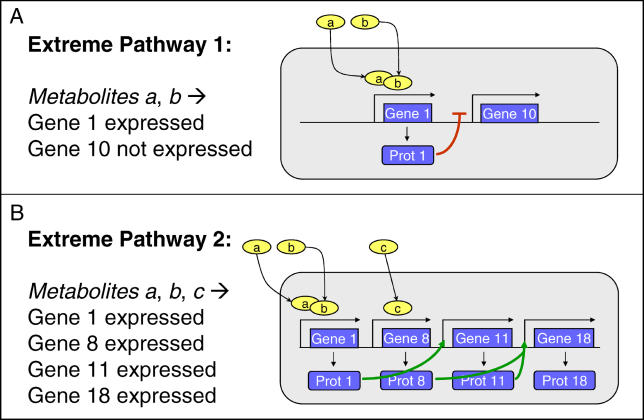
Extreme Pathways for the Prototypic TRSTwo examples of extreme pathways of the prototypic TRS are highlighted for the environment in which all six metabolites (a through f) are present. In pathway 1, the presence of Metabolite a and Metabolite b activates the expression of Gene 1, and Protein 1, the product of Gene 1, inhibits of the expression of Gene 10 (A). In pathway 2, the presence of Metabolite a and Metabolite b activates the expression of Gene 1; Protein 1 activates the expression of Gene 11; the presence of Metabolite c activates the expression of Gene 8; and Protein 8, the product of Gene 8, and Protein 11, the product of Gene 11, together activate the expression of Gene 18 (B).